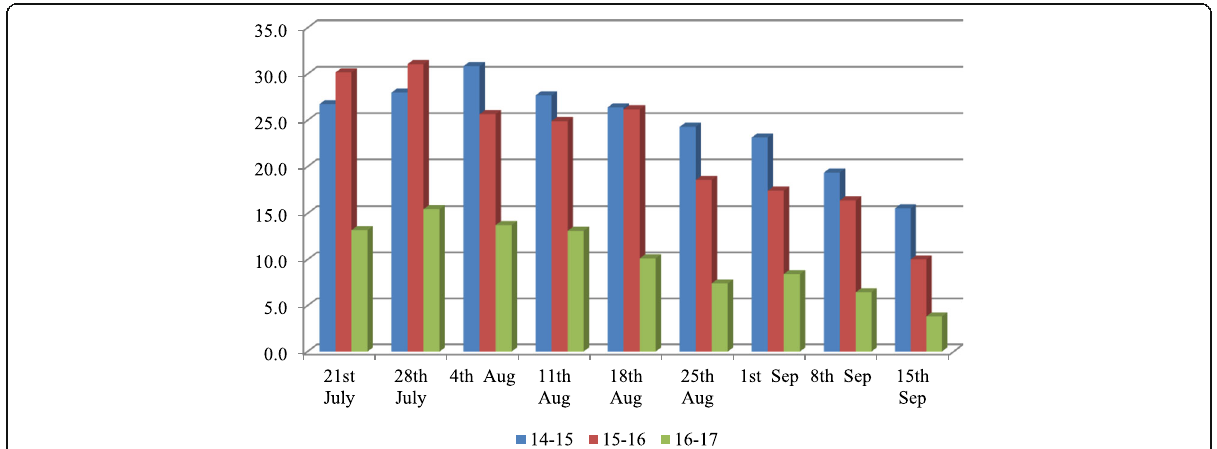
Fig. 1 Seed Cotton yield (q/ha) as influenced by dates of sowing in 2014-15, 2015-16 and 2016-17